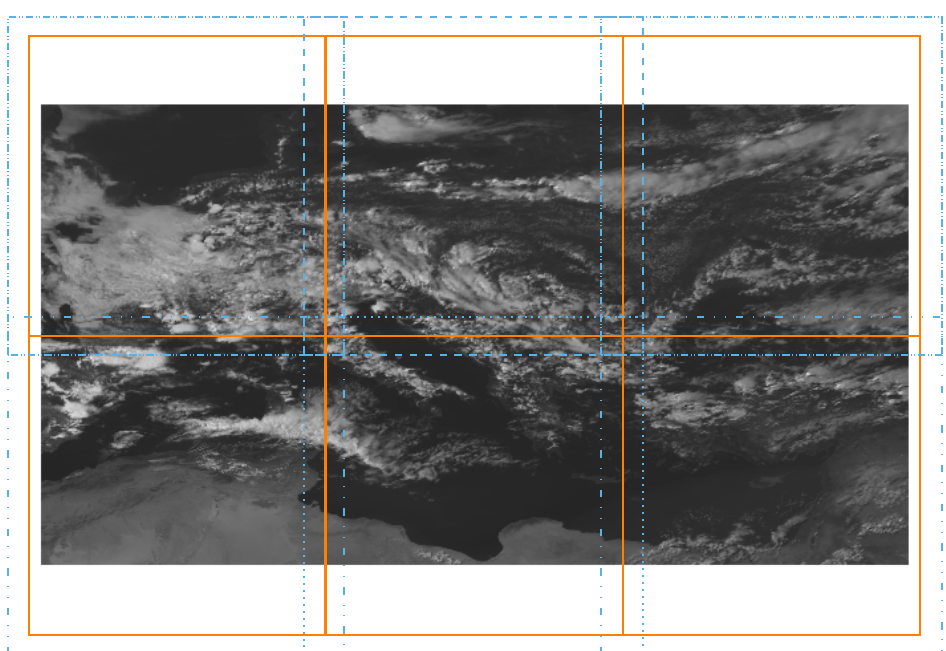
Figure A1. Example of the applied domain decomposition scheme into six slightly overlapping subdomains, shown for VIS006 (grayscale), 20160604 12:00 UTC. The non-overlapping regions are shown in orange, and their boundary (overlapping) regions are shown in